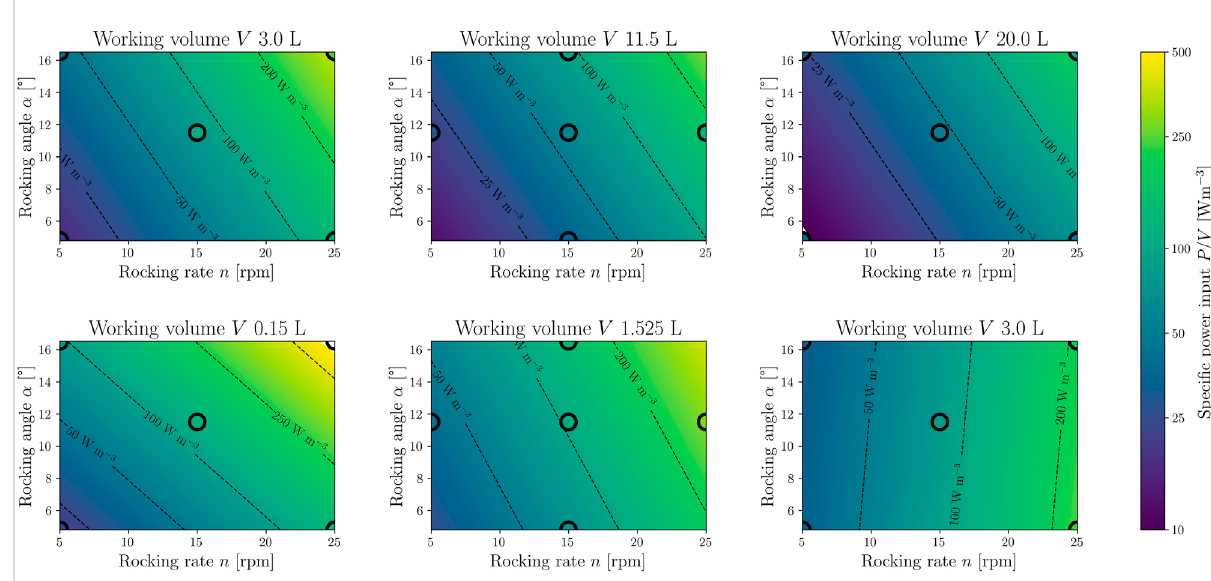
FIGURE 9 Response surface model (RSM) for the time-averaged speci fi c power input. The top row shows the model for the standard CELL-tainer con fi guration( N =15, DF =11, R 2 =0.83, RMSE =0.89 W m − 3 )withthreedifferentworkingvolumes(3.0L,11.5Land20.0 L).Thelowerrowshowsthe RSM ( N = 15, DF =10, R 2 = 0.90, RMSE =2.05 W m − 3 )for the con fi guration with expansion channels(0.15L, 1.525L and 3.0 L). The black circles mark processparametersettingson which CFDsimulations wereperformedto createthemodel, andthe fi llingcolorcorrespondstotheexact value of the CFD